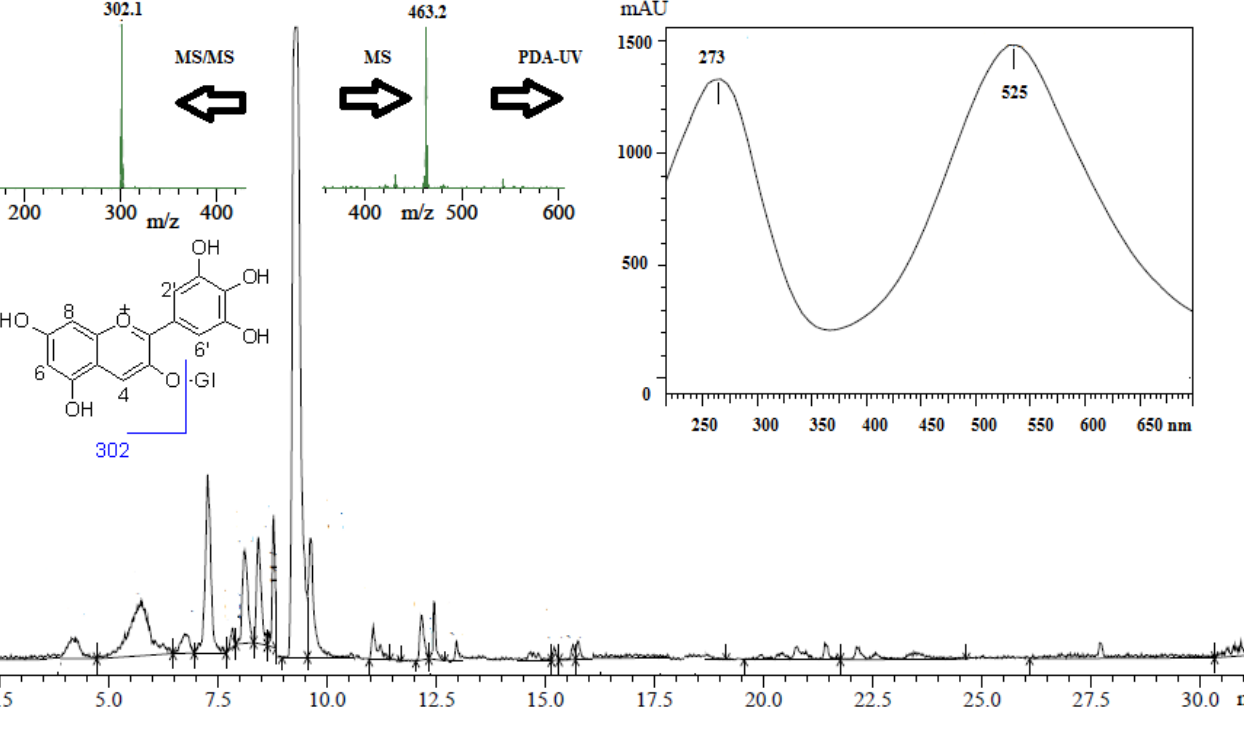
Figure 1. Total ion chromatogram of PEAME analyzed by UPLC-PDA-MS/MS in negative ion mode, showing the m / z 463 at retention time 8.12 min, its PDA-UV absorbance at λ max at 273 and 525 nm, and its MS/MS fragmentation to m / z 302. The structure of delphinidin-3- O -glucoside is shown. Table 1. UPLC-MS/MS identification of the compounds in PEAME. R t : retention time. Anthocyanins are highlighted in green. (*) denotes a molecular ion of [2M-H] −